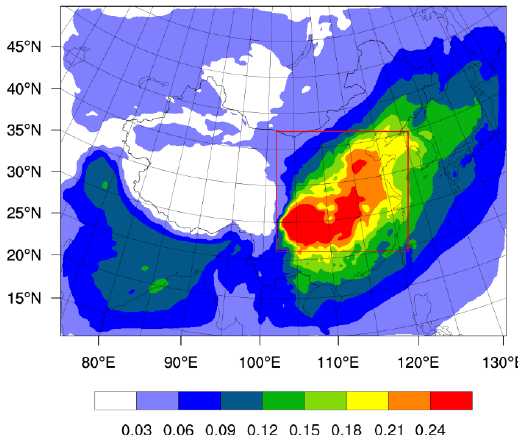
Figure 5. Spatial distribution of annual average sulfate AOD over East Asia in 2010, based on the WRF-Chem model.